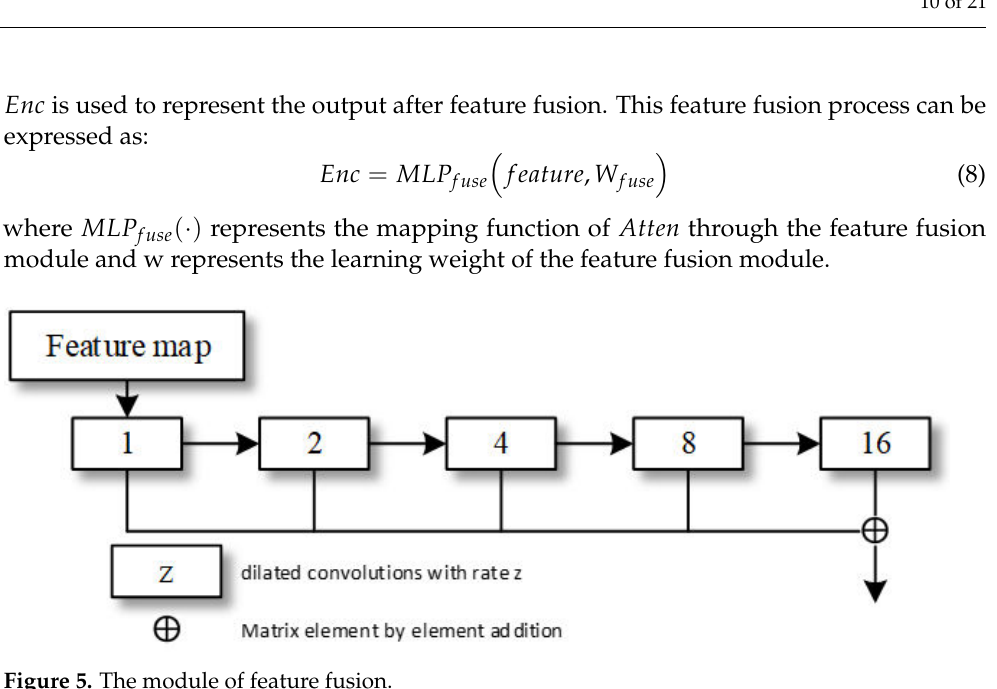
Figure 5. The module of feature